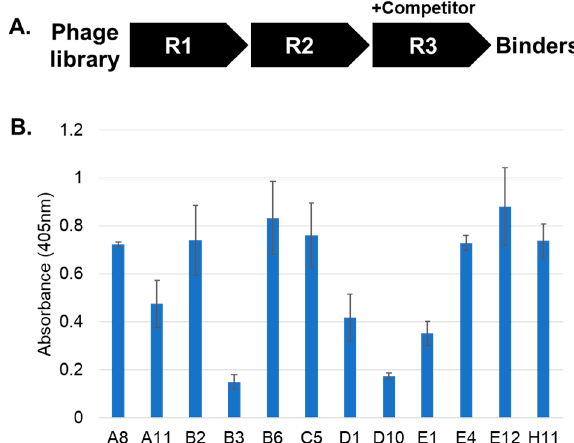
Figure 2. Affinity selection process and ELISA of 12 output clones. ( A ). An M13 bacteriophage library, displaying variants of a thermostable Forkhead-associated 1 (FHA1) H domain, was screened through three rounds (R1–R3) of affinity selection. During R3, excess phosphopeptide was added for off-rate competition, and recovered clones were examined for binding ( B ). Biotinylated Akt1-pT308 peptide was captured on a neutravidin-coated plate and probed with FHA variants that were detected by an M2-HRP conjugated antibody. Error bars represent standard deviation of triplicate measurements.